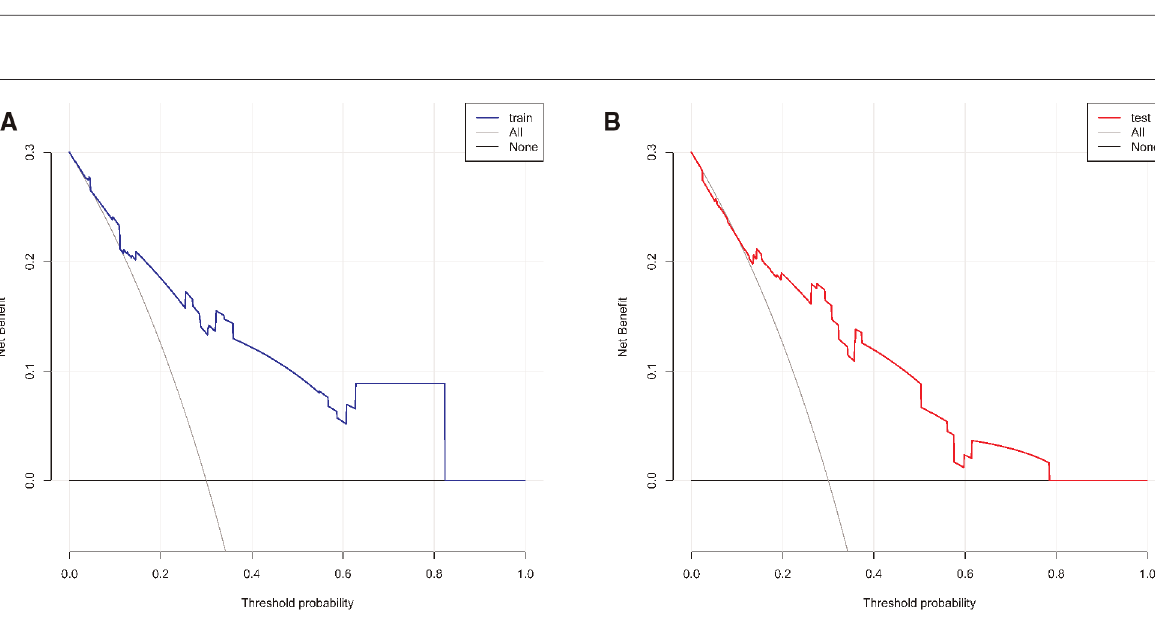
FIGURE 4 The decision curve analysis for the nomogram. ( A ) Training cohort. ( B ) Validation